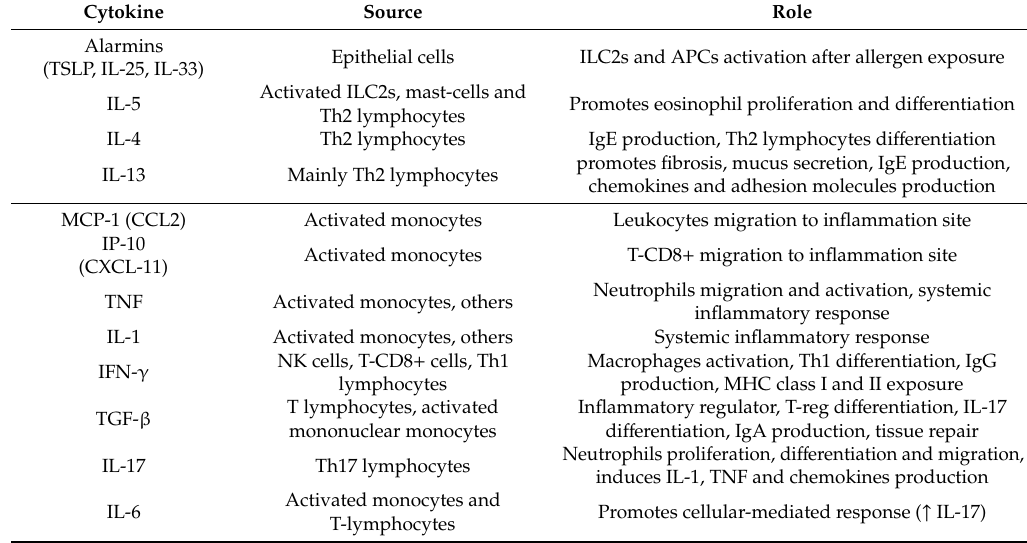
Table 1. Main cytokines involved in the asthma–obesity link [11]. Cytokines above the separation line are involved in Th2 response, while cytokines beneath the line are involved in Th1 response. Abbreviations: TSLP, thymic stromal lymphopoietin, IL, interleukin, MCP-1, monocyte